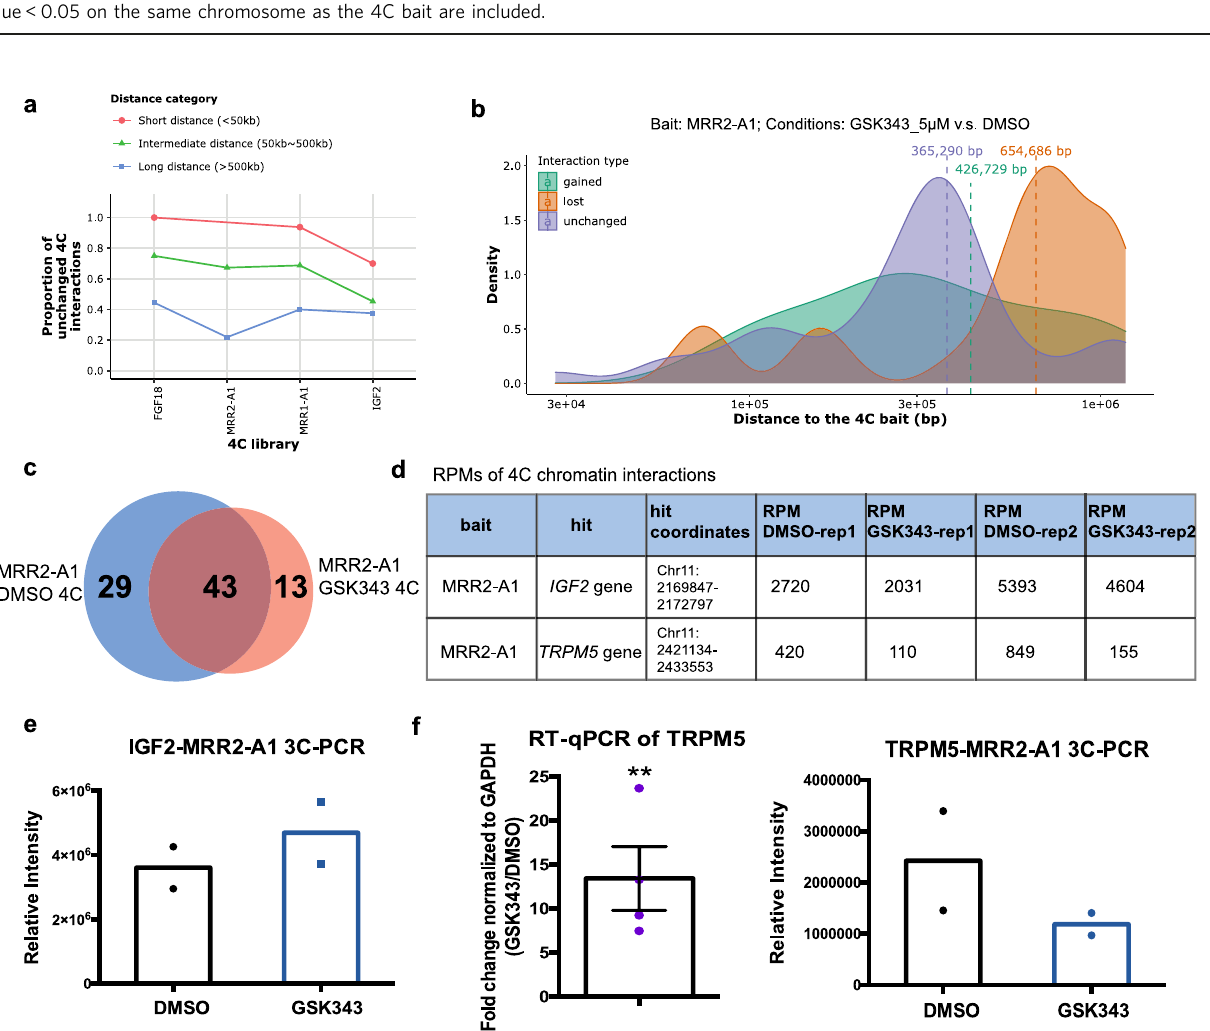
Fig. 8 MRR-associated gene expression and chromatin interactions changes after EZH2 perturbation. a H3K27me3 ChIP-seq signal at peaks from DMSO-treated and 5 μ M GSK343-treated K562 cells. Top panel: average H3K27me3 signal of H3K27me3 peaks in DMSO and GSK343 condition. Middle panel: H3K27me3 signal of DMSO H3K27me3 peaks in DMSO and GSK343 condition. Bottom panel: H3K27me3 signal of GSK343 H3K27me3 peaks in DMSO and GSK343 condition. b Expression changes of genes associated with different types of peaks in 5 μ M GSK343-treated K562 cells. One-tailed wald test was used for testing signi fi cant upregulation. All the P values of genes in each category are aggregated using Lancaster aggregatin 90 . * p < = 0.05; ** p < = 0.01; *** p < = 0.001; **** p < = 0.0001; ns, p > 0.05. Box and whiskers plot: whiskers were extended to the furthest value that is no more than 1.5 times the inter-quartile range. The boxes represent the 25th percentile, median, and 75th percentile. c 4C results of FGF18 in DMSO and 5 μ M GSK343- treated K562 cells. The colors of 4C interactions are based on the distal interacting regions. Blue: repressive; orange: active; green: both; gray: quiescent. The height of the 4C is shown in Reads Per Million (RPM). The ChIP-seq signal and peaks of H3K27ac, H3K27me3, and H3K4me3 are shown. d Zoomed-in view of 1000 kb region downstream of the 4C bait indicated in c . Top and bottom panel: 4C interactions in DMSO and 5 μ M GSK343 conditions. Y-axis is scaled to the distance to the 4C bait. The color palette is the same as c . Middle panel: types of the 4C HindIII fragment. Gray, unchanged (present in both conditions); Red, gained (only present in 5 μ M GSK343 condition); Green, lost (only present in DMSO condition). All the 4C regions are shown in two alternate rows to have a better visual separation. e Zoomed-in view of 50 kb region downstream of the 4C bait indicated in c . The details of each panel are the same as in d . f Density plot of different categories of 4C interactions on the same chromosome as the bait. All the 4C interactions that have p value < 0.05 on the same chromosome as the 4C bait are included.